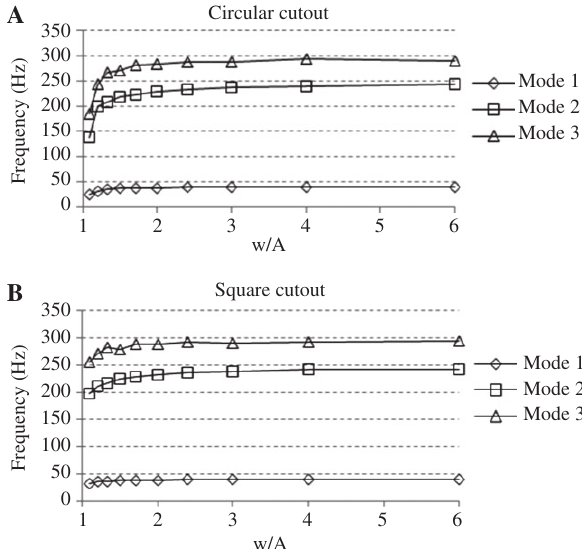
Figure 9 Cutout size for (A) circular cutout and (B) square cutout.